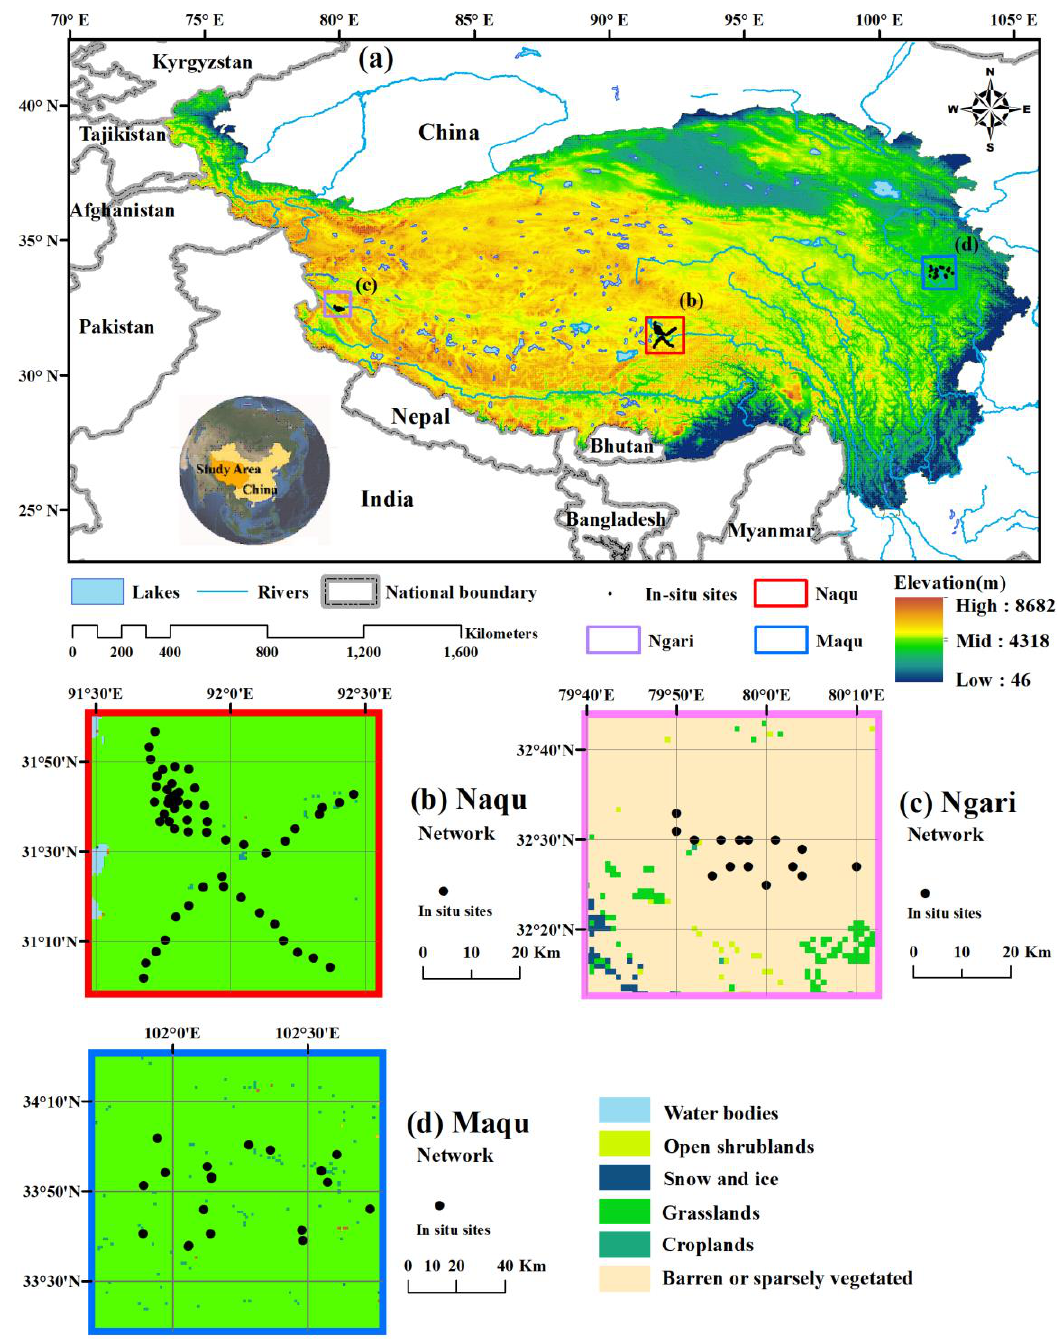
Figure 1. ( a ) The QTP study area and the ( b ) Naqu, ( c ) Ngari, and ( d ) Maqu in situ SM Table 1. Summary of the basic information of the three in situ networks. Networks